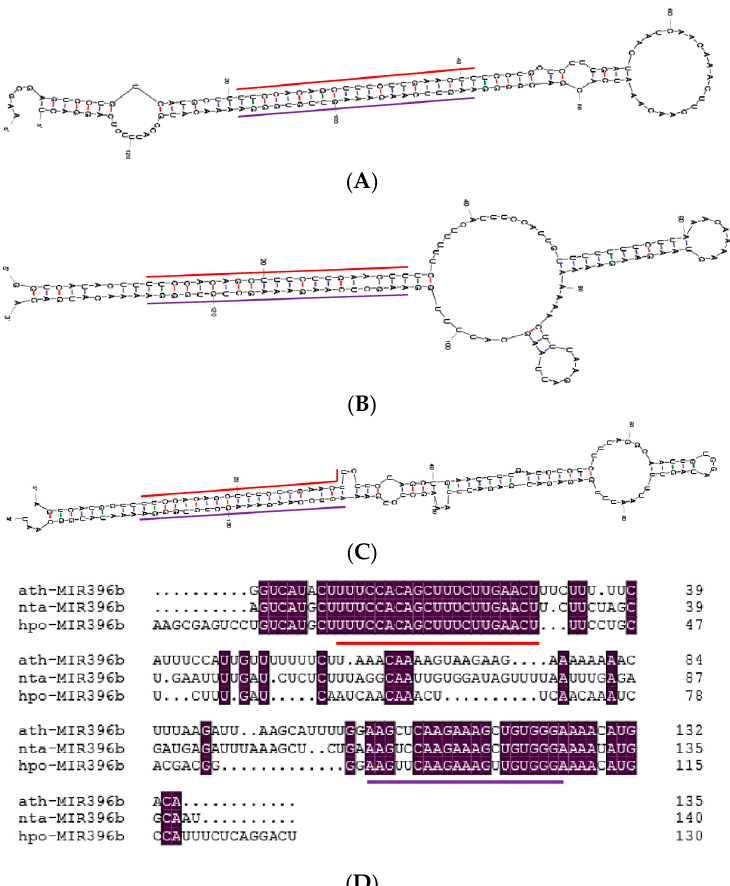
Figure 2. The comparison of the stem-loop structure of miR396b among three plant species: ( A ) H. polyrhizus (minimum free energy dG = − 55.80 kcal / mol); ( B ) A. thaliana (minimum free energy dG = − 43.59 kcal / mol); ( C ) N. tabacum (minimum free energy dG = − 55.90 kcal / mol); ( D ) Alignment sequence analysis of MIR396b from the three species. miR396b and miR396b* are shown by the red and purple line in Figure 2. Nucleotides that are identical are highlighted in purple